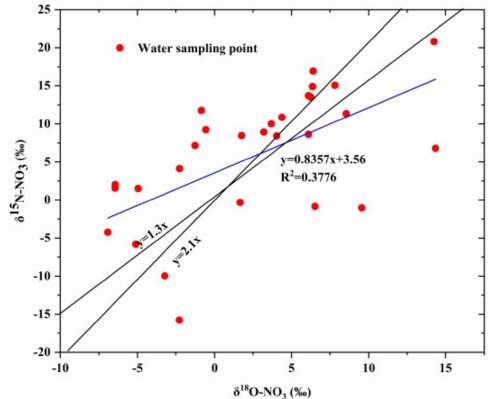
Figure 9. The relationship between δ 15 N-NO 3 and δ 18 O-NO 3 in the water body of the study